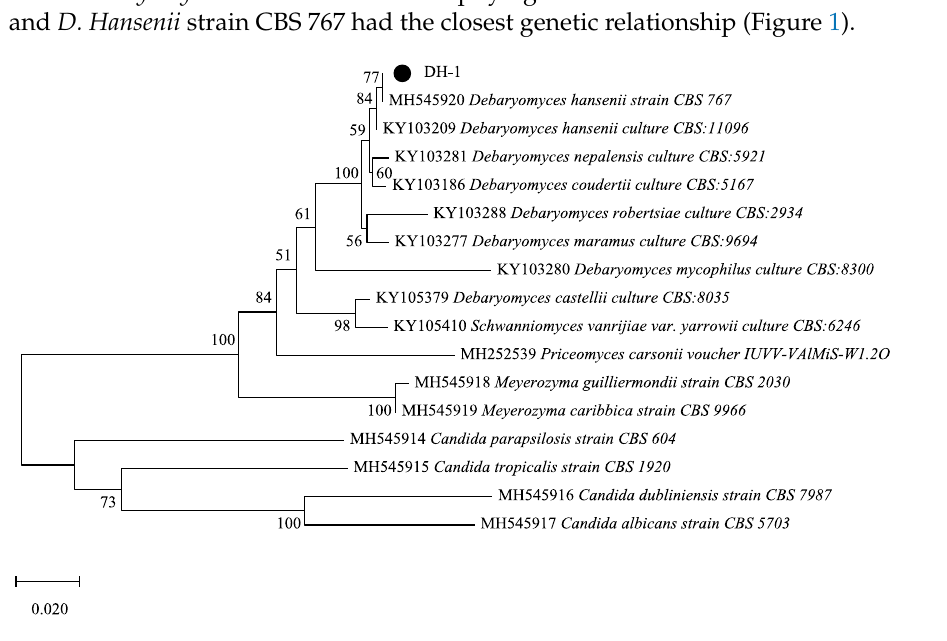
Figure 1. The phylogenetic tree of the strain D. Hansenii DH-1. Numbers at branches represent bootstrap values (above 50%, 1000 replicates) of the neighbor-joining analysis.